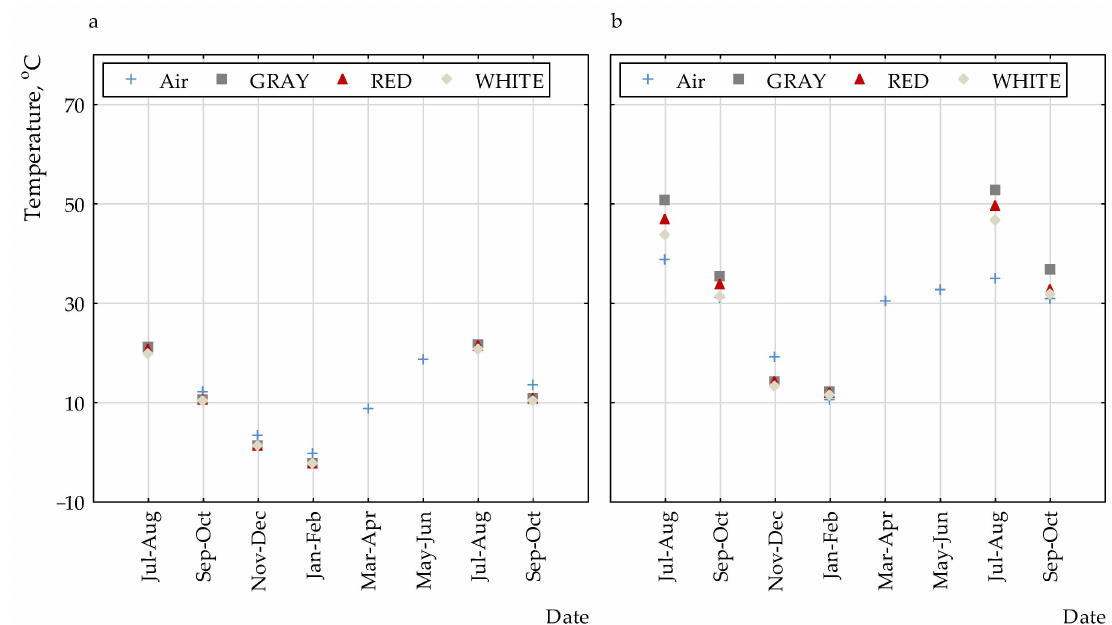
Polymers 2021 , 13 , x Figure 5. Temperatures of the partition surface for the period of 1 July 2017 to 31 October 2018: ( a ) average and ( b ) maximum.